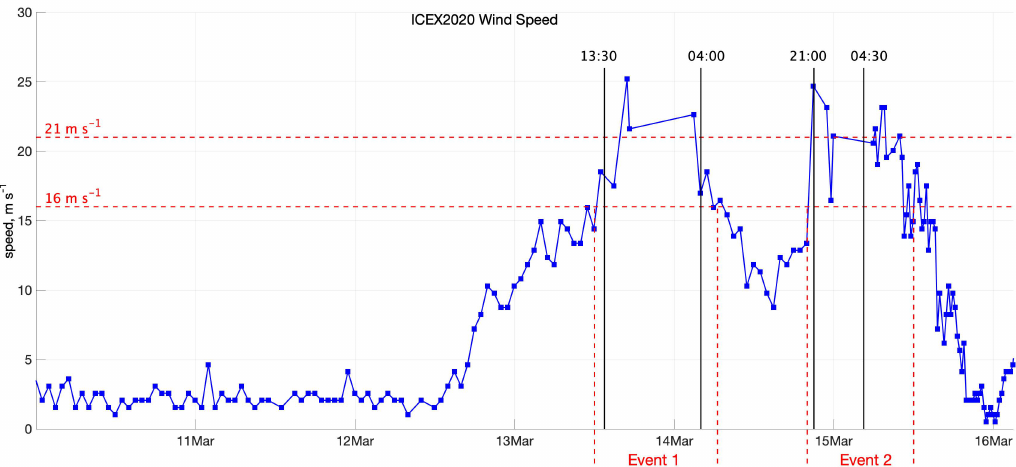
Figure 4. Wind speed (meters per second) measured at Camp Seadragon from 10–16 March 2020. Two wind events are marked by red vertical dashed lines when the wind speed exceeded the 16 m s –1 threshold needed to excite flexural-gravity waves. A 21 m s –1 wind speed is also marked. The black vertical lines mark the times that bound the wave response from Figure 5. All times are in UTC.